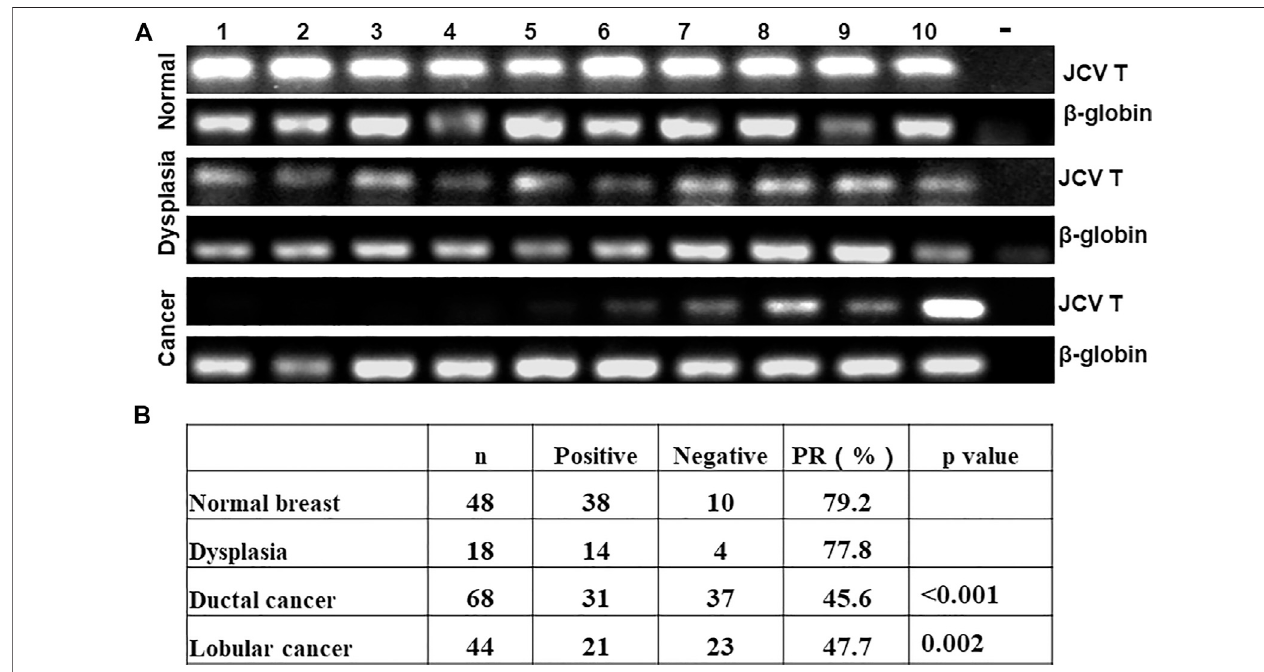
FIGURE 1 | Detection of JCV T antigen in breast carcinogenesis. β -globin was positive in all cases of normal tissue, dysplasia, and cancer of the breast. T antigen waspositiveinsomecancercasesbynestedPCR (A) .ThepositiveratesofJCVTantigenwerecompared betweencancer,dysplasia,andnormaltissue (B) .-,negative control; PR, positive rate.